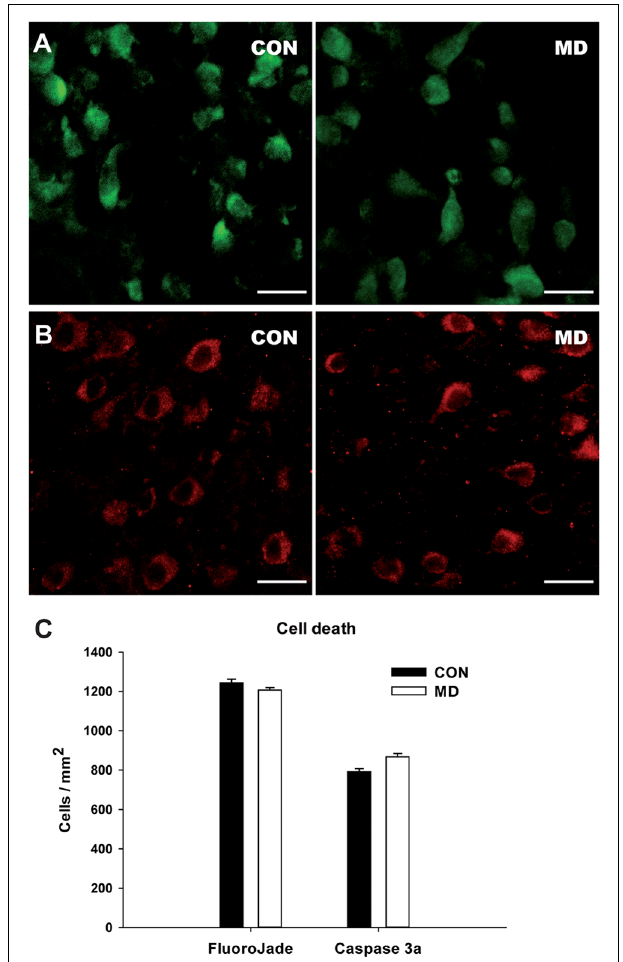
FIGURE 5 | Cell death in the cortex at P15. (A,B) Representative images of the FlouroJade (A) and activated caspase 3 (B) stainings in the prefrontal cortex of P15 rats. Left panels show control (CON) and right panels MD rats. (C) Shown are mean values + standard error of the mean (SEM) for profile densities of labeled cells ( p > 0.05, t -test, n = 4 animals per group). Scale bars: 20 µ